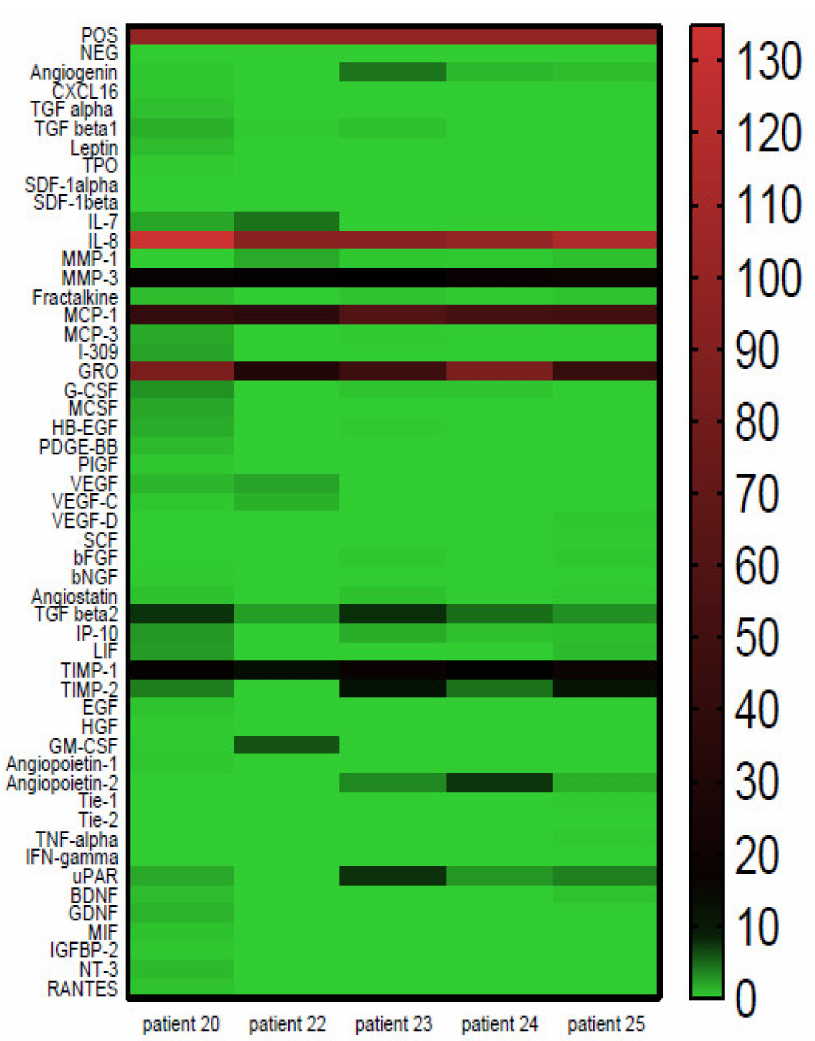
Figure 2. Secretion of cytokines by primary MSCs derived from the adipose tissue of patients with chronic wounds. Secretion of cytokines as evaluated by RayBio Custom C-series human Cytokine Antibody Array for a panel of 50 cytokines. Cell cultures, established with the same cell number, were conducted under serum-free conditions. Cytokine level was expressed as a heat map where green color represents low level and red represents high level of detected